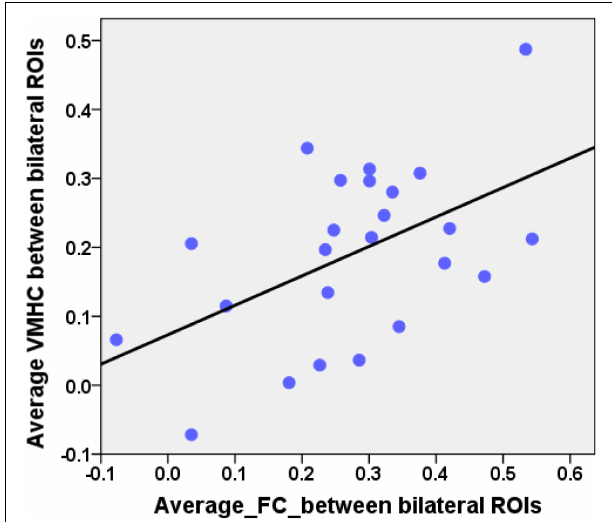
FIGURE 5 | Correlation between the average VMHC values and the average FC values in patients. The average VMHC values were extracted from the bilateral HF and bilateral LTC of the group comparison results of the whole brain VMHC analyses. The average FC values were extracted from the bilateral HF and bilateral LTC of the NBS results of the DMN. Scatterplot showing significantly positive correlation between the average VMHC values and the average FC values in patients ( r = 0.512, p = 0.015). Age and gender were controlled during this correlation